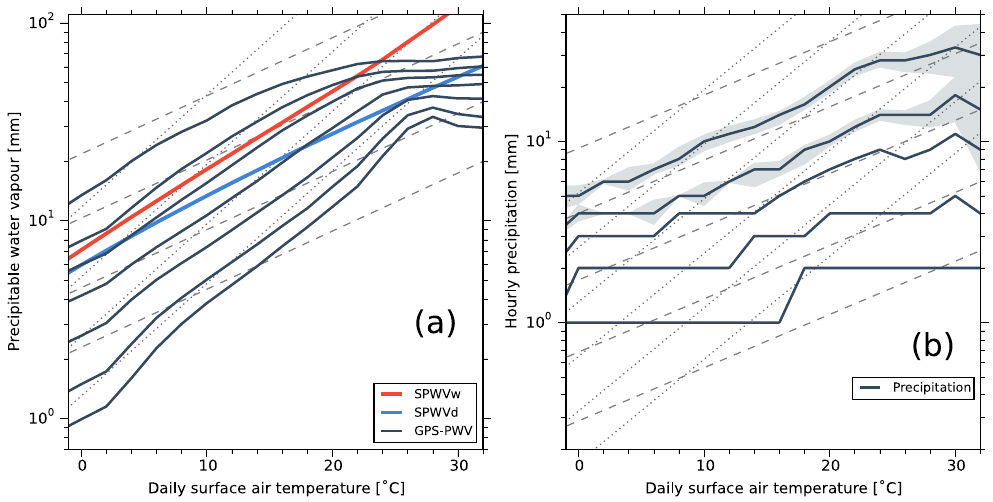
Figure 2. Percentiles of hourly PWV and precipitation on a logarithmic scale as a function of daily surface temperature (SAT). ( a ) Hourly GPS-PWV percentiles. Solid black lines are, from top to bottom, the 99th, 90th, 75th, 50th, 25th, 10th and 5th percentiles of hourly GPS-PWV. Red and blue lines are the estimated SPWV w and SPWV d profiles, respectively. ( b ) Hourly precipitation percentiles. Solid black lines are, from top to bottom, the 99th, 90th, 75th, 50th, and 25th percentiles of hourly precipitation. Dashed and dotted grey lines in both panels are the exponential relations corresponding to one and two times the Clausius–Clapeyron relation, respectively. The shaded area, plotted only for 99th and 90th percentiles, indicates the 90% confidence intervals estimated using the bootstrap method (see